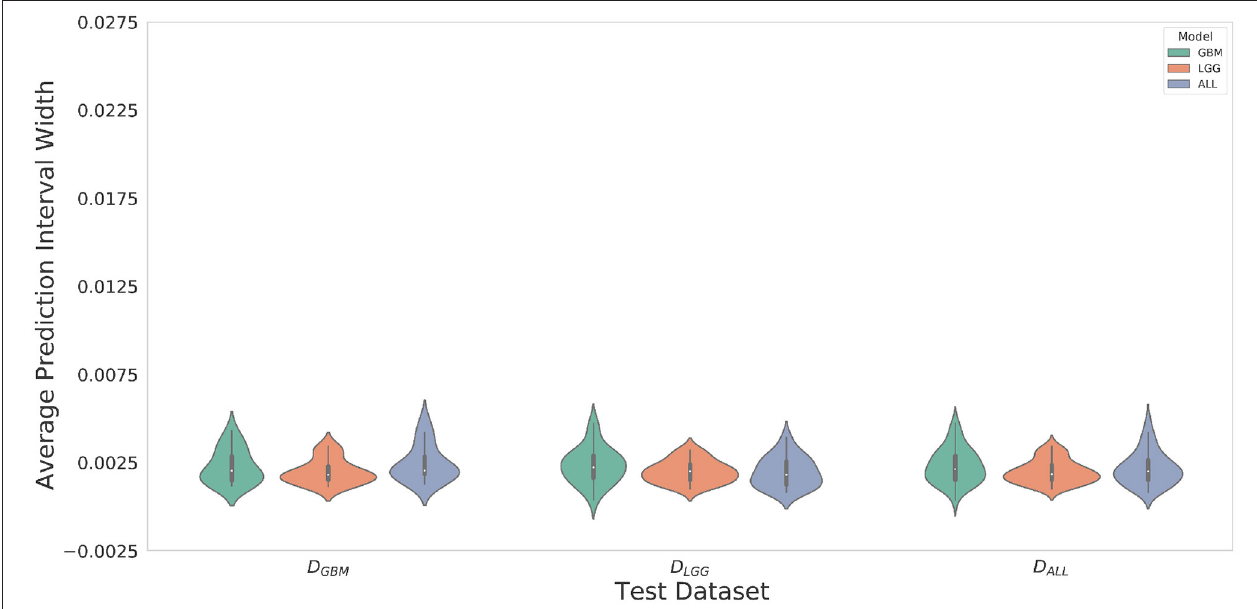
FIGURE 8 | The violin plot indicates models have equal median confidence while segmenting GBM and LGG patients due to greater number of non-tumor pixels in the datasets. The x-axis represents the datasets. The y-axis represents average prediction intervals. Models are sorted by hues and grouped together by test dataset.